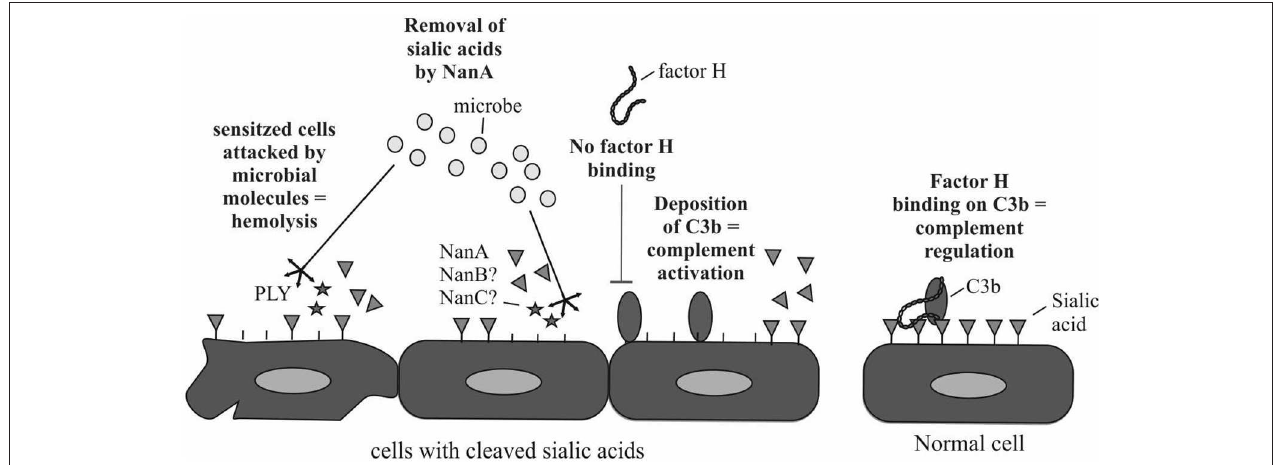
FIGURE 6 | Schematic illustration of the putative mechanism how NanA could reduce complement regulation by factor H on the cells and sensitize cells for attack by complement and thereby lead to cell damage. In addition, NanA could increase the susceptibility of cells to attack by pneumolysin (PLY) or other virulence factors.